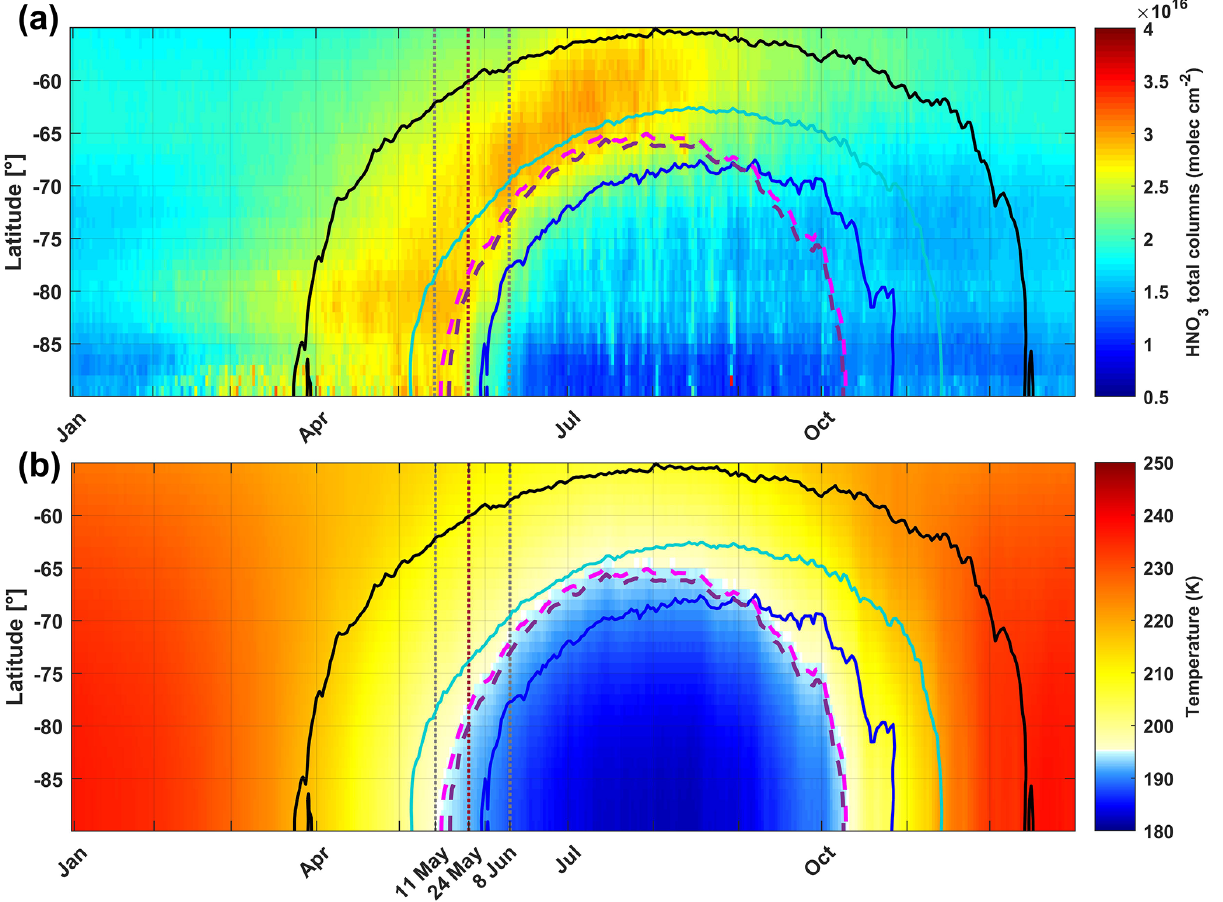
Figure 5. Zonal distributions of (a) HNO 3 total columns (in molec . cm − 2 ) from IASI and (b) temperatures at 50hPa from ERA-Interim (in K) in the 55–90 ◦ S geographical latitude band and averaged over the years 2008–2017. Three isocontours for the climatological (2008– 2017) and zonally averaged PV of − 5 (black), − 8 (cyan) and − 10 (blue) ( × 10 − 5 Km 2 kg − 1 s − 1 ) at 530K. The isocontours for the 195K climatological (2008–2017) zonally averaged temperature (pink) and the averaged 194.2K drop temperature (purple) at 50hPa are superim- posed. The vertical dashed grey lines mark the earliest and latest dates for the averaged drop temperature in the 10-year IASI record, and the red line indicates the average date for the drop temperatures calculated in the area delimited by the − 10 × 10 − 5 Km 2 kg − 1 s − 1 PV